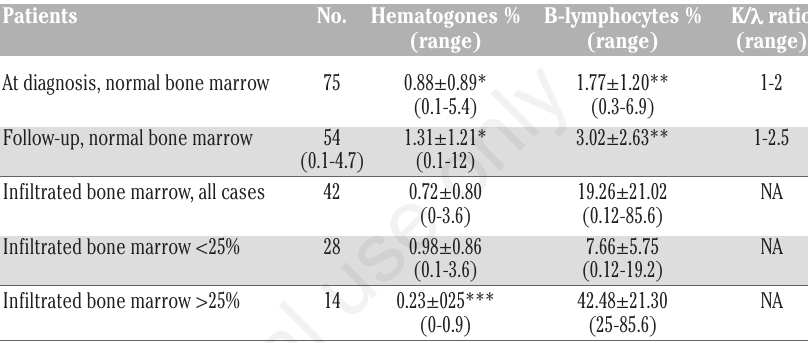
Table 2. Percentages of hematogones and